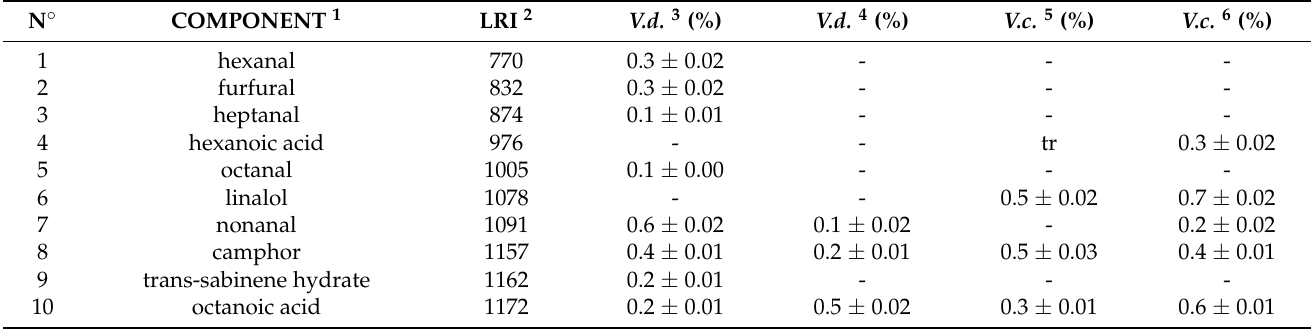
Table 1. Chemical composition (peak area percentage) of Viola dubyana and Viola calcarata